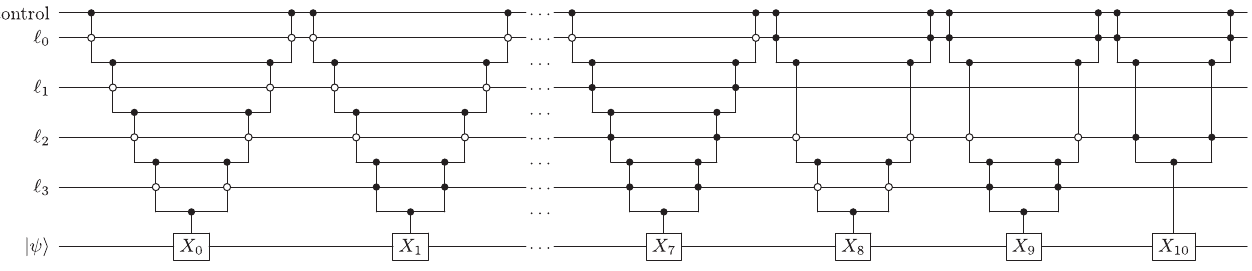
FIG. 5. The “ sawtooth ” circuit resulting from removing unnecessary bits from Fig. 3 and then adding AND operations from Fig. 4 to combine the controls for performing a controlled indexed X l operation with L ¼ 11 possible